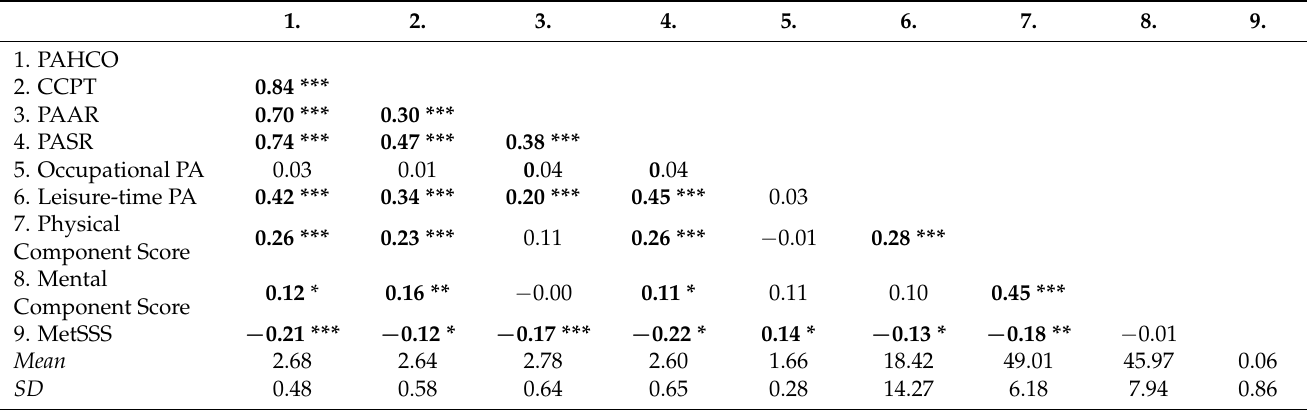
Table 2. Means, SDs, and bivariate correlation coefficients for the main